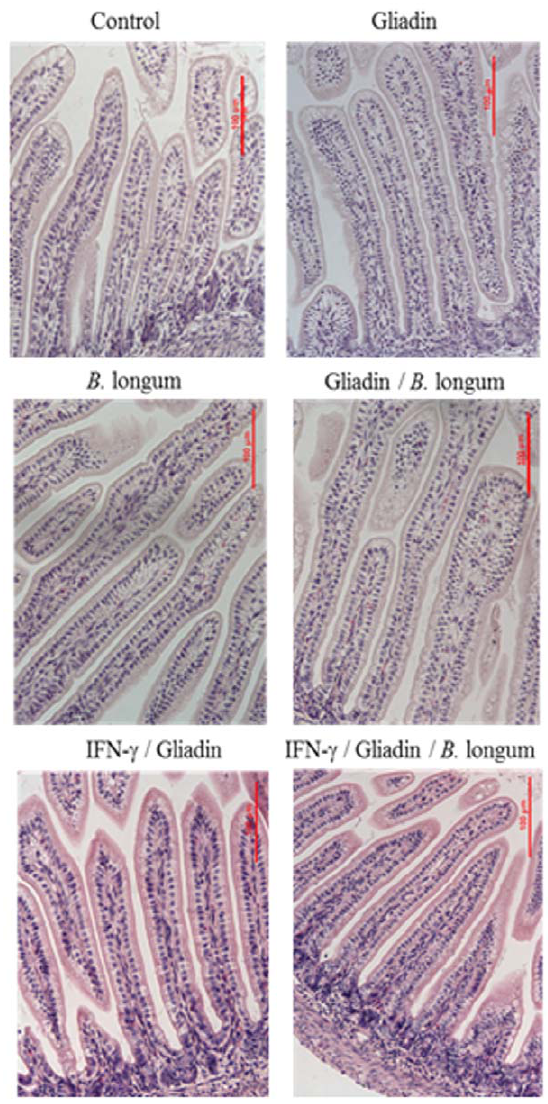
Figure 1. Histology of jejunal tissue sections of different experimental rat groups, stained with hematoxylin-eosin showing the different degree of cellular infiltration in the lamina propria of animals sensitized or not with IFN- c and fed gliadins and B.longum CECT 7347. Scale bar, 100 m m.